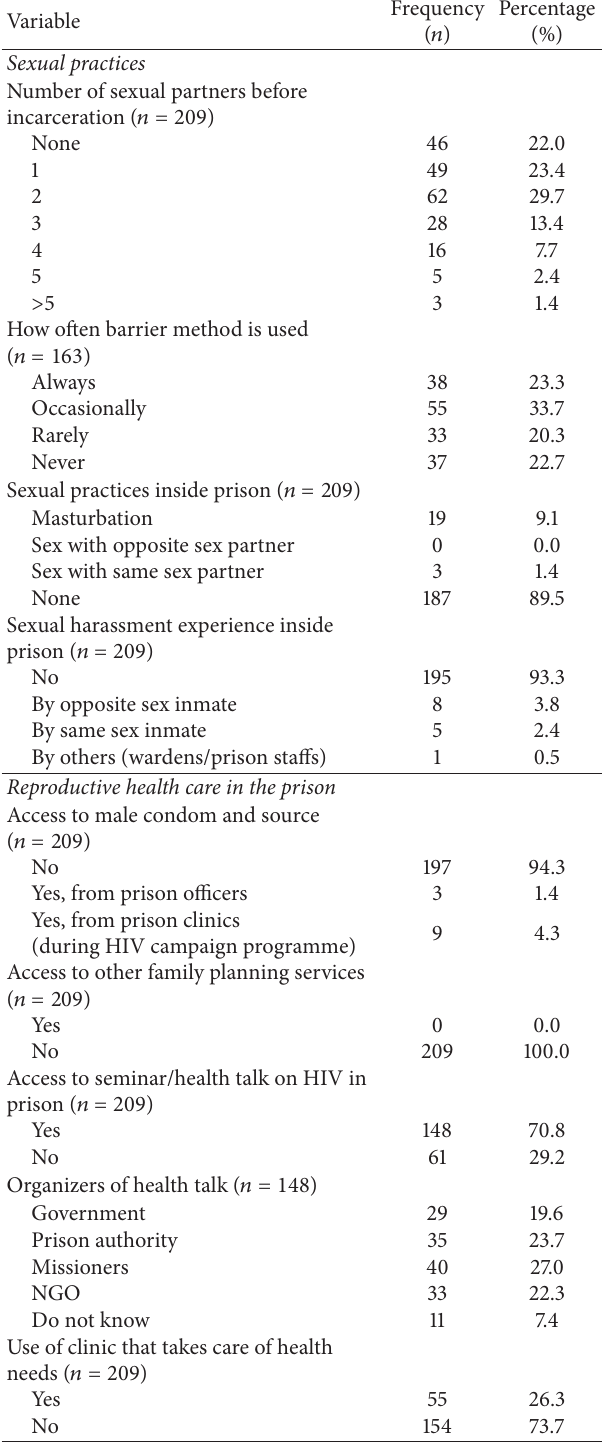
Table 5: Sexual practices and reproductive health care of respon-